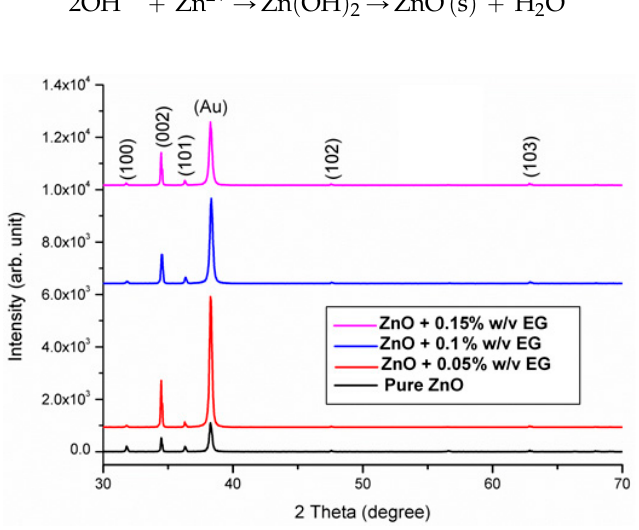
Figure 1. XRD of undoped ZNRs and ZNRs with EG, and all of them indicating a c-axis oriented structure.